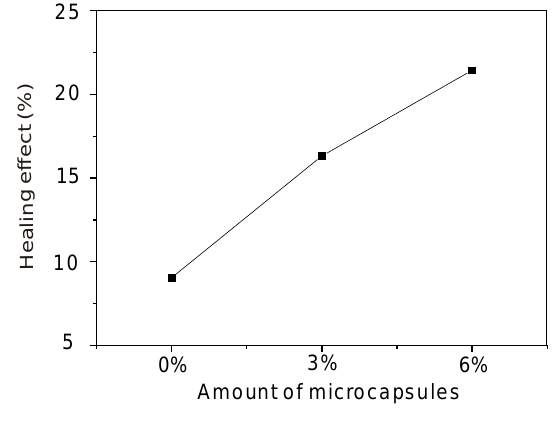
Figure 13. Permeability healing effect versus amount of